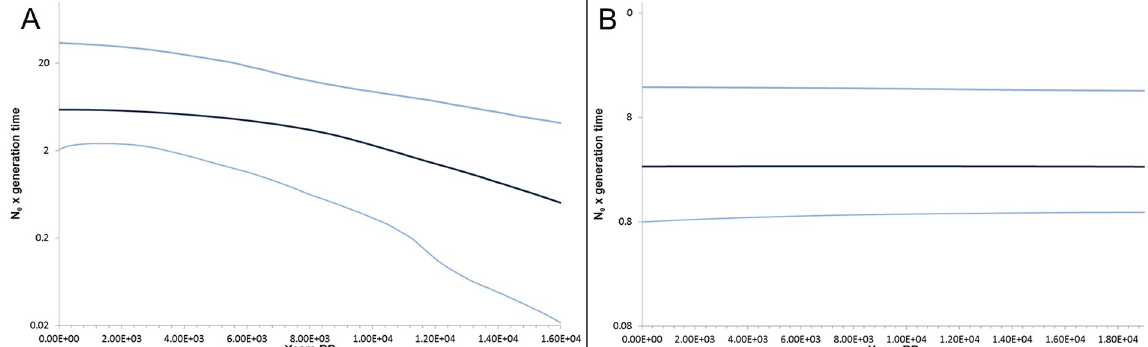
Fig 7. Bayesian skyline plot of Lucanus cervus created with the COI dataset. The y-axis represents the product of effective population size (N e ) and generation time (with units in millions of years) on a logarithmic scale. The black line gives the median of effective population size through time and the blue lines represent the 95% highest posterior densities over the median estimates along the coalescent history. The x-axis gives years before present.